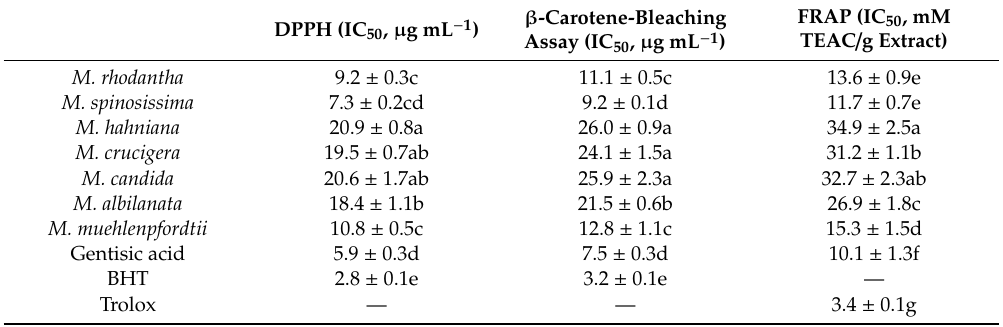
Table 3. DPPH and β -carotene bleaching acid of Mammillaria sp. stem extracts as well as gentisic acid.